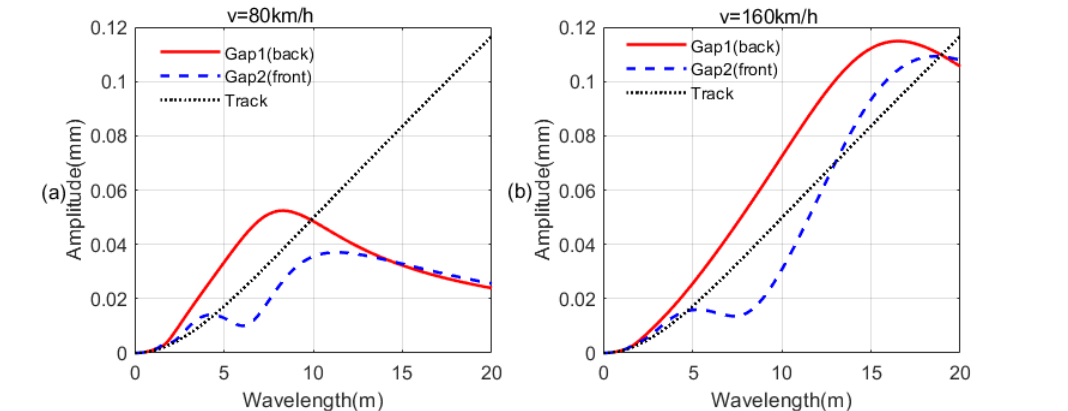
Figure 5. Amplitude spectrums at different speed vs. track wavelengths. ( a ) at 80 km/h, ( b ) at 160